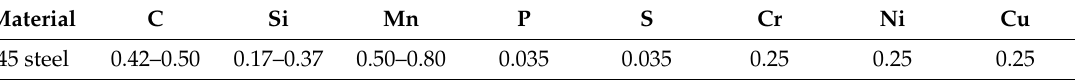
Table 2. The chemical composition of 45 steel (wt